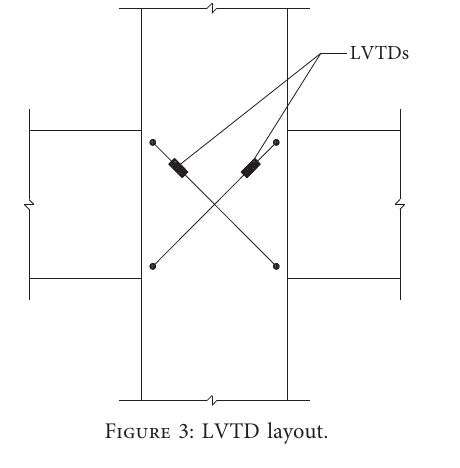
Figure 3: LVTD layout.